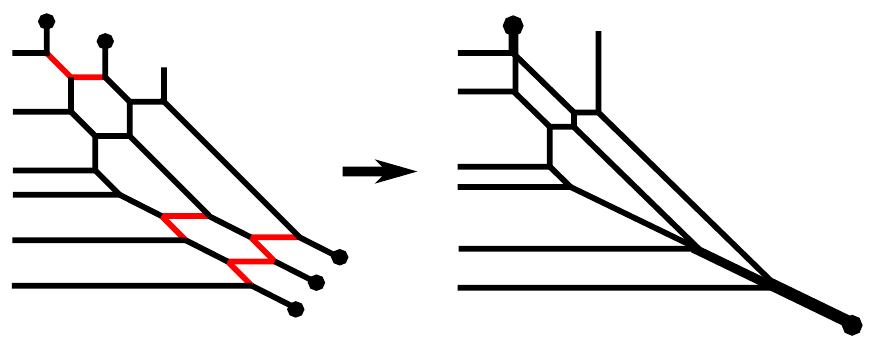
Figure 29 . Higgsing from a [SU(6) (cid:20) ] (cid:0) SU(4) 0 (cid:0) SU(2) quiver theory to [SU(6) (cid:20) +1 ] (cid:0) [1 AS ].